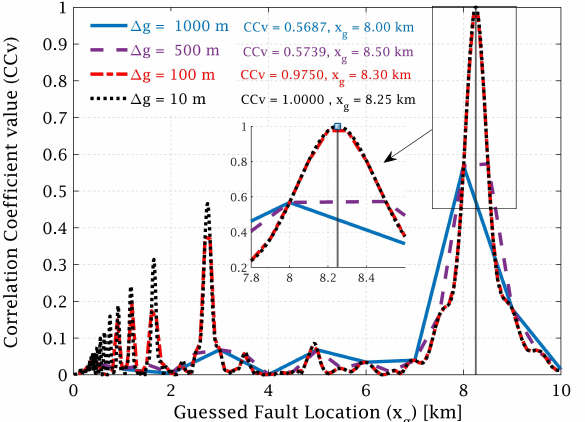
Figure 16. EMTR energy metric: considering different spatial steps in the fault estimation stage. The test fault location is 8.25 km.